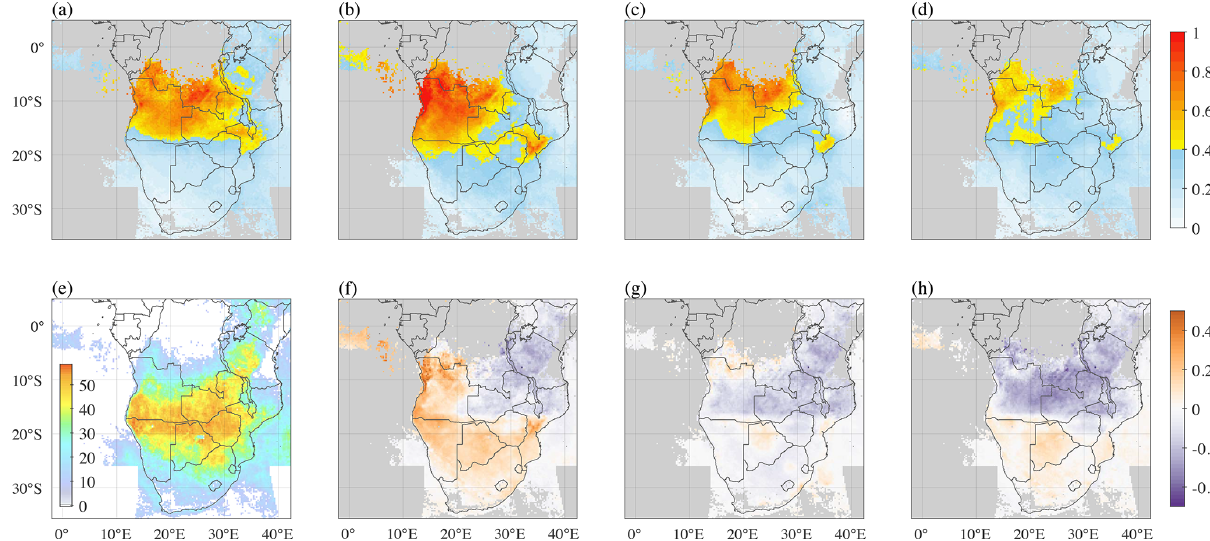
Figure 6. Monthly averaged aerosol optical depth at 550nm from (a) MODIS MAIAC, (b) WRF-VFEI, (c) CAMS reanalysis, and (d) MERRA-2 reanalysis during September 2016. (e) Number of observations per grid point weighted in the final average for each dataset. Panels (f) – (h) show the mean monthly bias from each dataset with respect to MODIS MAIAC. Gray areas represent grid points with no observations during the